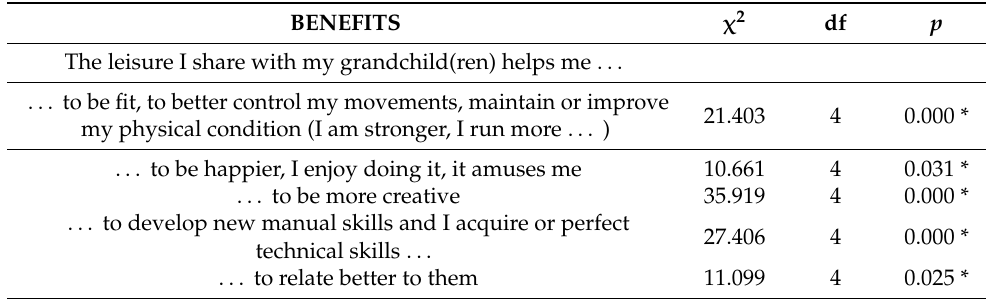
Table 3. Chi-square test: benefits of festive leisure activities in grandparents who share compared with grandparents who do not share.